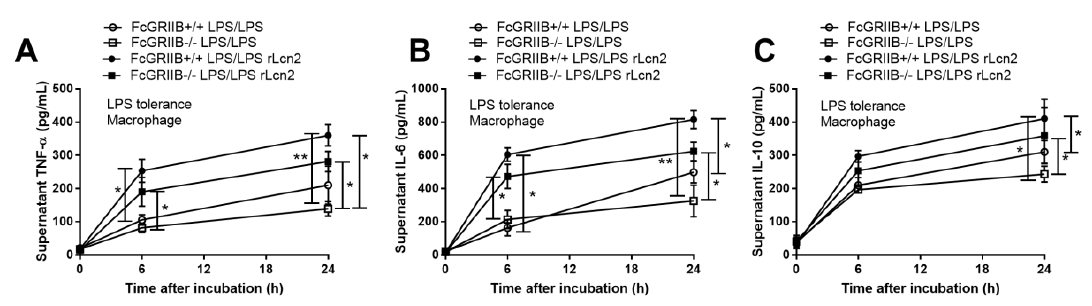
Figure 8. The impact of recombinant Lcn-2 (rLcn-2) against LPS tolerance (double LPS stimulation; LPS/LPS) in wild-type (WT) and FcGRIIb-/- macrophage as determined by supernatant cytokines ( A – C ) were demonstrated. (Independent triplicate experiments were performed for all experiments; *, p < 0.05; **, p < 0.01).